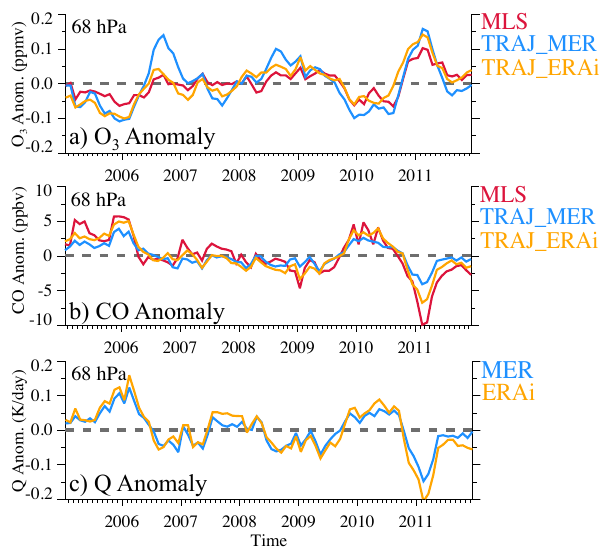
Figure 12. Interannual anomalies of (a) O 3 and (b) CO from MLS (red) and trajectory simulations driven by MERRA and ERAi in the tropical (15 ◦ N–15 ◦ S) lower stratosphere (68hPa). (c) shows interannual anomalies of total diabatic heating rates from MERRA and ERAi, which serves in our model as the vertical velocity. The trajectory results are weighted by the MLS averaging kernels.